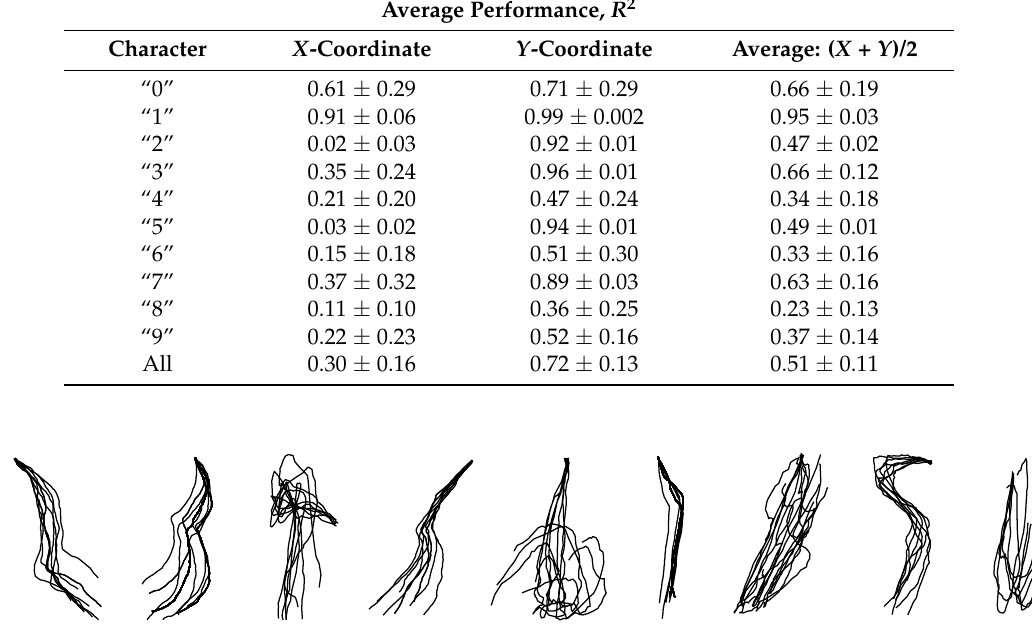
Figure 12. The randomly selected reconstructed numeric character of between-group reconstruction by the KF.